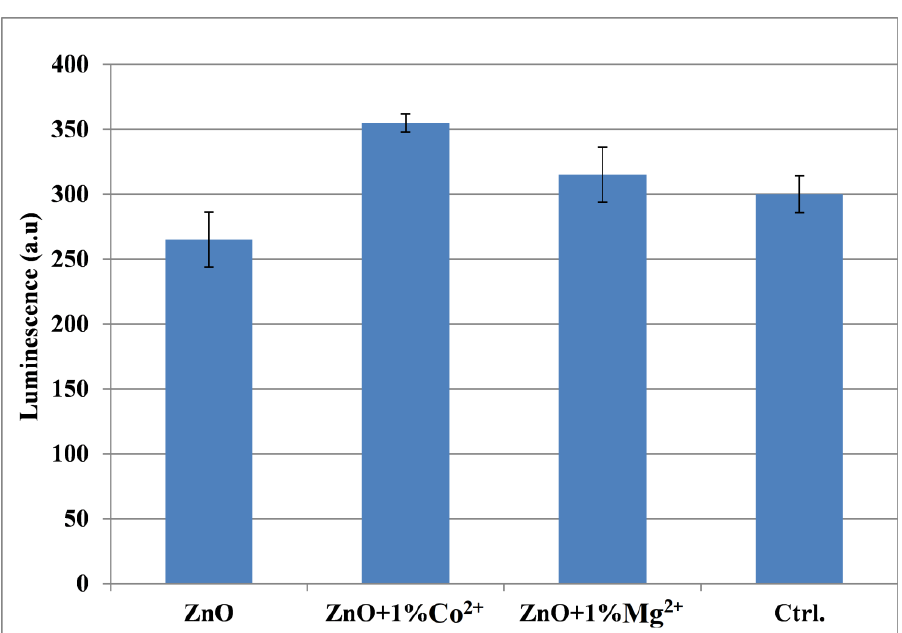
Figure 9. The fluorescence microscopy images performed on undoped and Co 2+ /Mg 2+ doped ZnO films coatings on TiAlV alloy substrate.